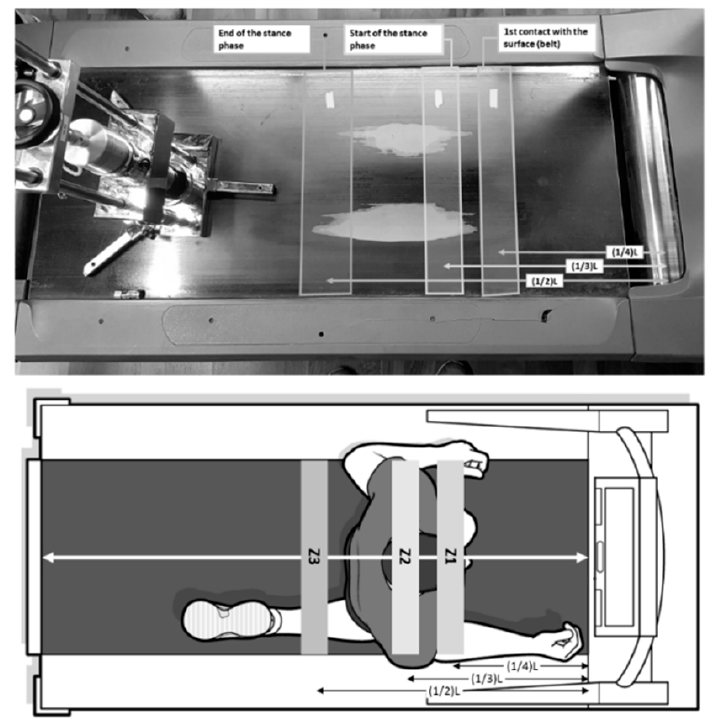
Figure 1. Location of the three different zones (Z) evaluated in each treadmill. Z1: (1/4)L; Z2: (1/3)L; and Z3: (1/2)L, where L is the total length of the treadmill, represented by the white line.